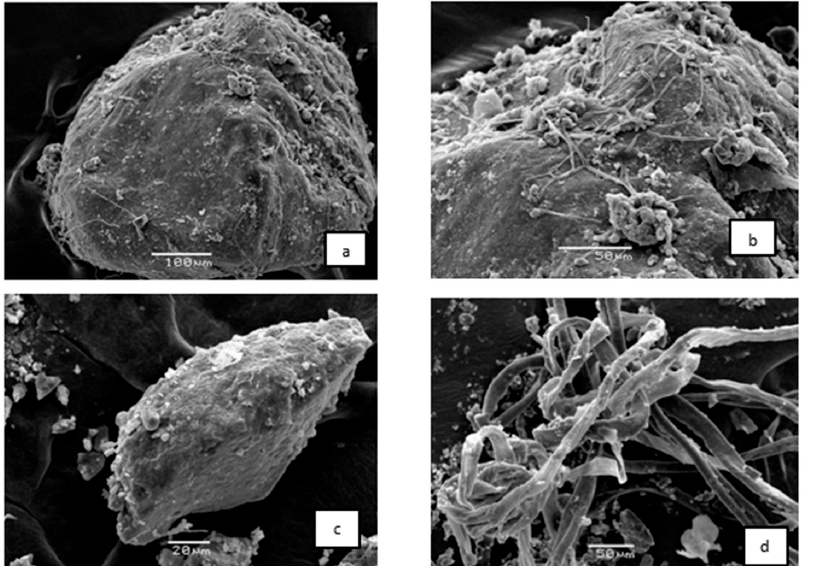
Figure 3. Atmospheric microparticles of biological origin on the surface of mineral grains: ( a , b )—hyphae-micromycetes; ( c )—Microorganisms on the surface of mineral particles; ( d )—Hyphae of fungi. SAM JSM-6380 LA. The scale is 100 µ m ( a ), 50 µ m ( b , d ), 20 µ m ( c ).